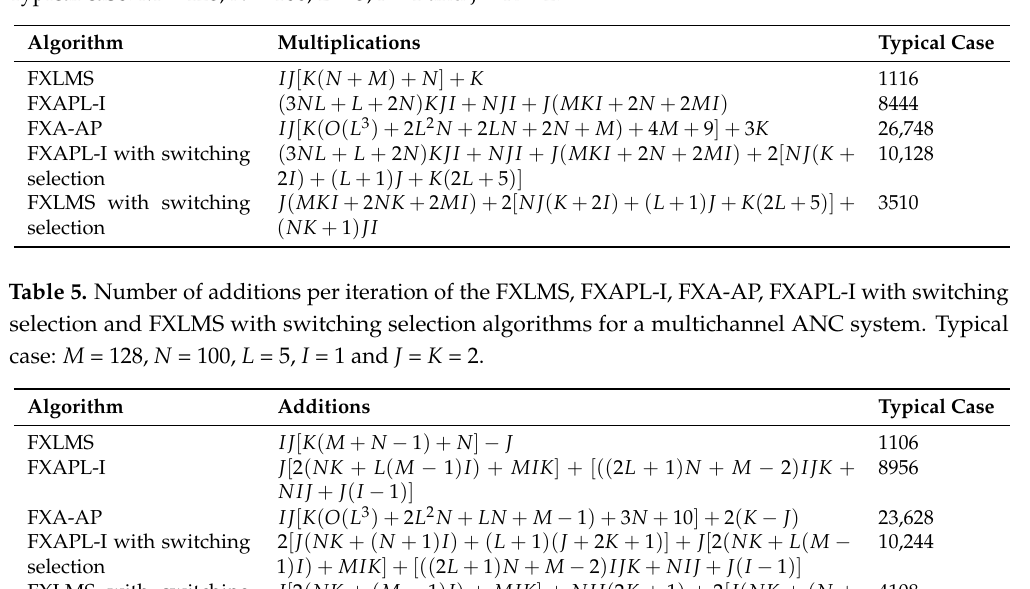
Table 4. Number of multiplications per iteration of the FXLMS, FXAPL-I, FXA-AP, FXAPL-I with switching selection and FXLMS with switching selection algorithms for a multichannel ANC system.